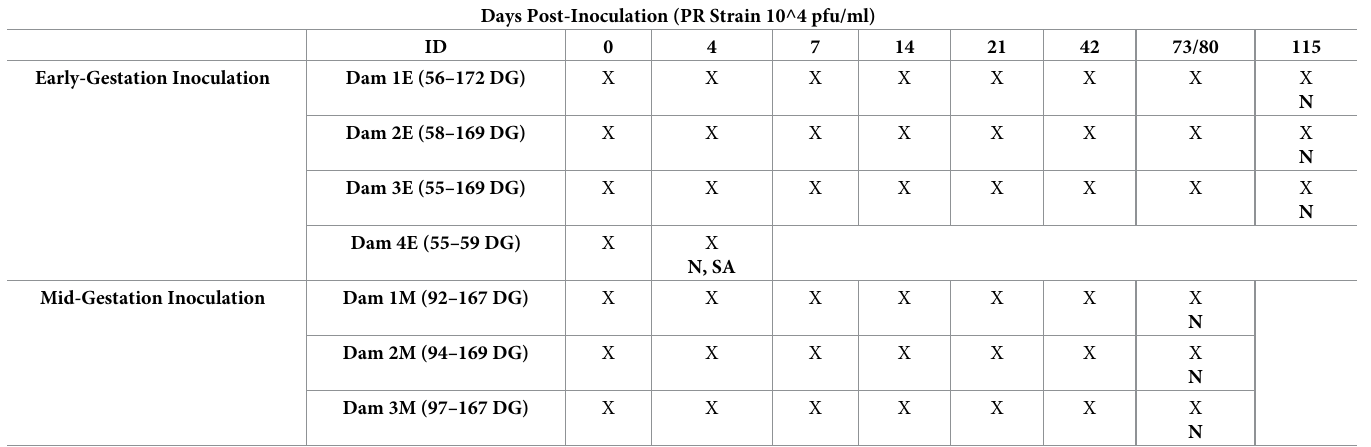
Table 1. Study design and timeline.